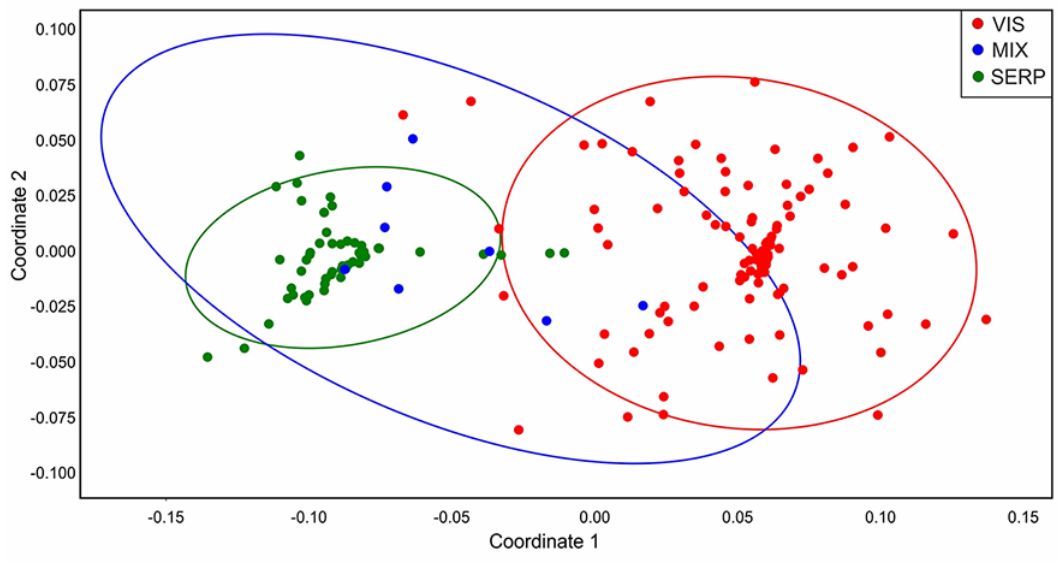
Fig. 4 Nonmetric multidimensional scaling (NMDS) scatterplot of studied specimens representing Arenaria serpyl- lifolia s. l. morphotypes (VIS, MIX,